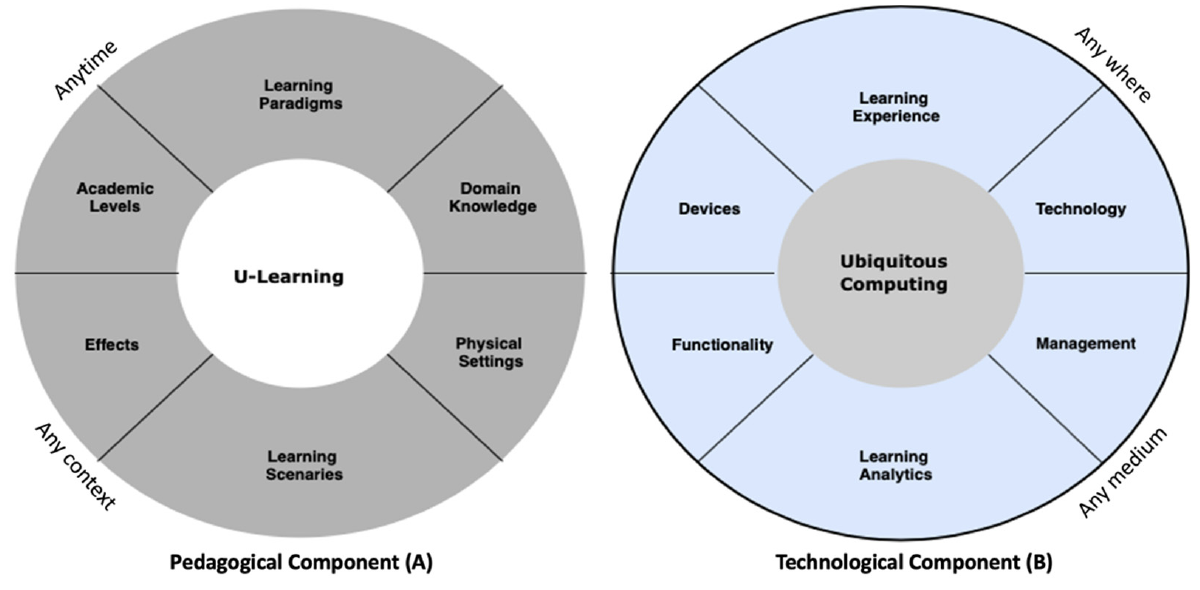
Figure 3. U-CLX Model Overview [2].